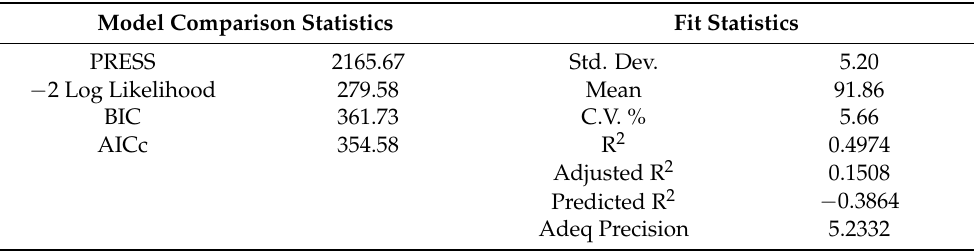
Table 5. Model comparison and fit statistics for CIP removal.